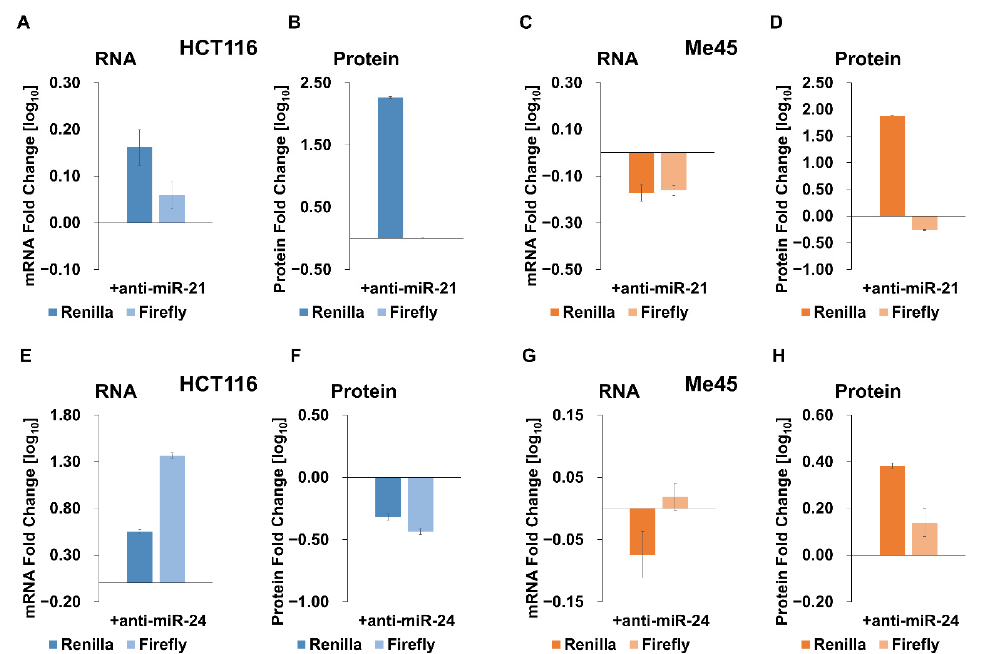
Figure 6. Influence of anti-miR oligonucleotides on miRNA-21 ( A – D ), or miRNA-24 ( E – H ) on the expression of miRNA-targeted Renilla and co-transfected non-targeted firefly reporter genes. Bar graphs represent the decimal logarithm of the ratio of mRNA ( A , C , E , G ) or protein ( B , D , F , H ) levels in the presence to these in absence of anti-miR oligonucleotides. Dark blue and dark orange columns show changes in Renilla luciferase expression, whereas light blue and light orange show values for firefly luciferase.